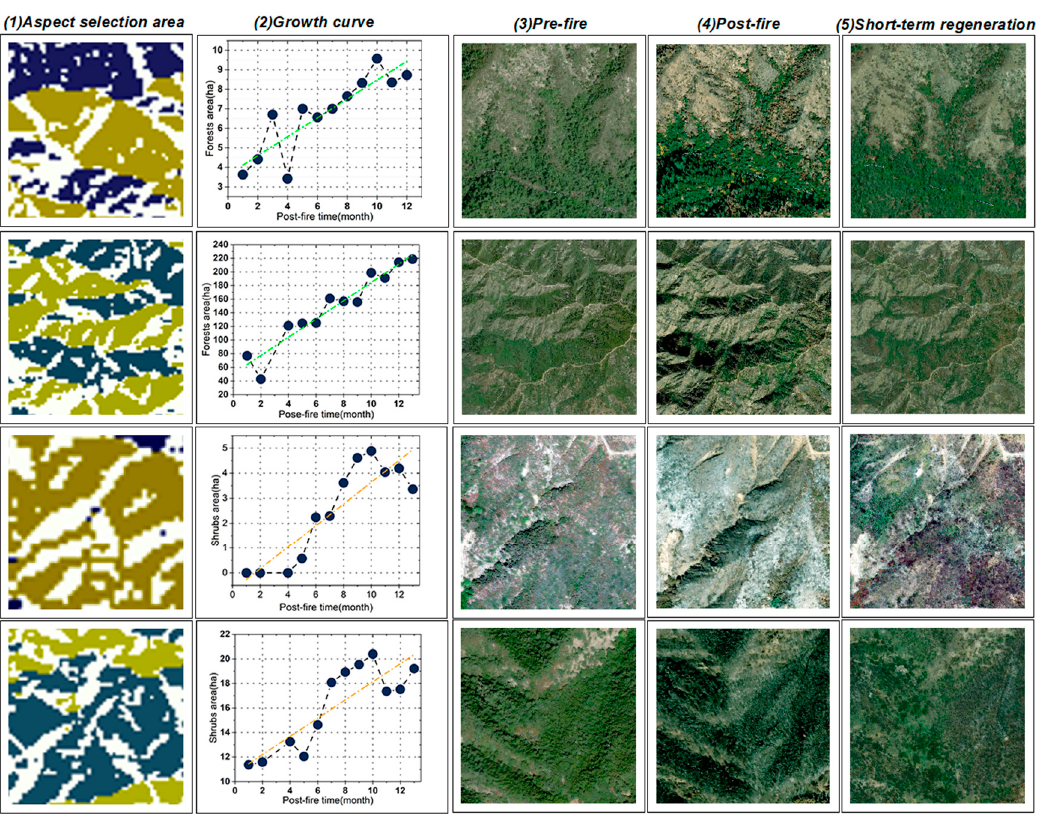
Figure 13. Sunny and shady slope vegetation community regeneration map. The order is: forests—sunny slope; forests—shady slope; shrubs—sunny slope; and shrubs—shady slope.